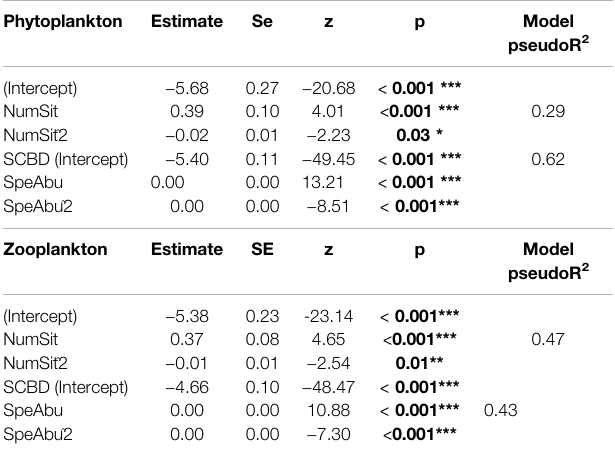
TABLE4| Resultsofbetaregressionanalyseswhenspeciescontributionstobeta diversity (SCBD) was explained by species abundance, site occupancy, and their quadratic